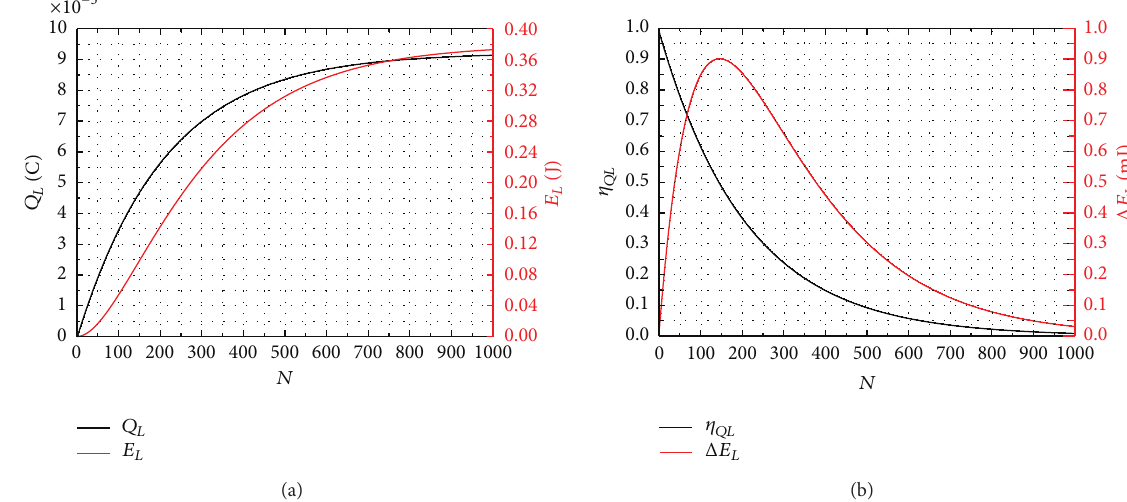
Figure 9: (a) The charges and energy stored on storage capacitor versus the cycle number. (b) The charges transfer efficiency and energy increment per cycle versus the cycle number.